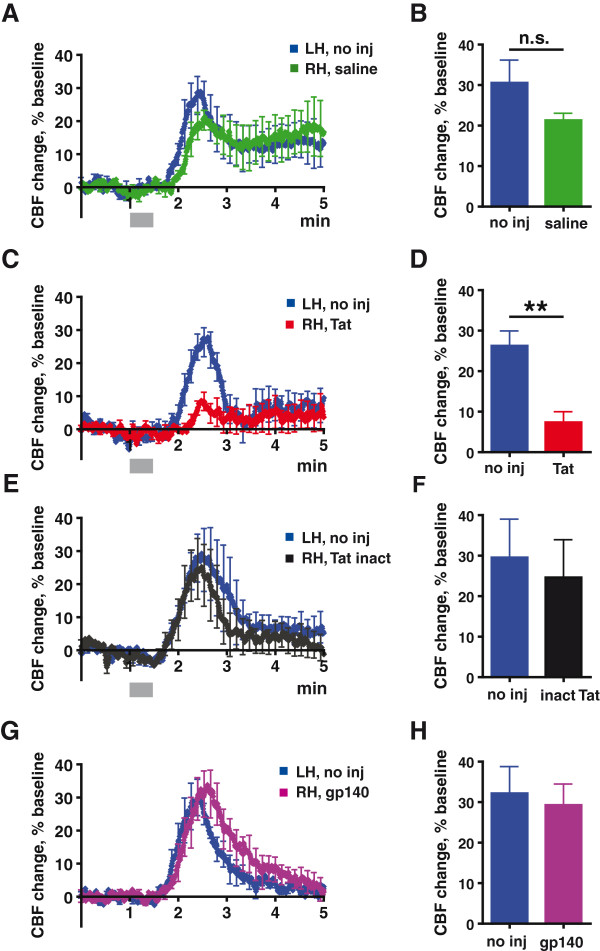
Acute exposure to Tat dysregulates cerebrovascular response to hypercapnic challenge. In all panels, cerebral blood flow (CBF) change in response to 30-second exposure to 6% CO2, was measured by bilateral laser Doppler flowmetry (BLDF), in c57Bl mice. (A) CBF change 48 hours after injection with saline into right hemisphere (RH). Intact left hemisphere (LH) serves as a control. Results represent mean values from three mice. (B) Maximum CBF reached in response to 6% CO2, for the data in (A). n.s.: not significant; nonparametric permutation test. (C) CBF change 48 hours after injection with Tat into RH. Intact LH serves as a control. Results represent mean values from four mice. (D) Maximum CBF reached in response to 6% CO2, for the data in (C). **P <0.01, nonparametric permutation test. (E) CBF change 48 hours after injection with heat-inactivated Tat into RH. Intact LH serves as a control. Results represent mean values from four mice. (F) Maximum CBF reached in response to 6% CO2, for the data in (E). (G) CBF change in mice 48 hours after injection with recombinant HIV-1 Env into RH. Intact LH serves as a control. Results represent mean values from four mice. (H) Maximum CBF reached in response to 6% CO2, for the data in (G). (A, C, E, F) Values are expressed as a percentage change from baseline CBF, defined as the mean CBF measured during the one- minute period immediately preceding delivery of CO2. The shadowed area along the X-axis represents the duration of the hypercapnic challenge. All data represent mean ± SEM